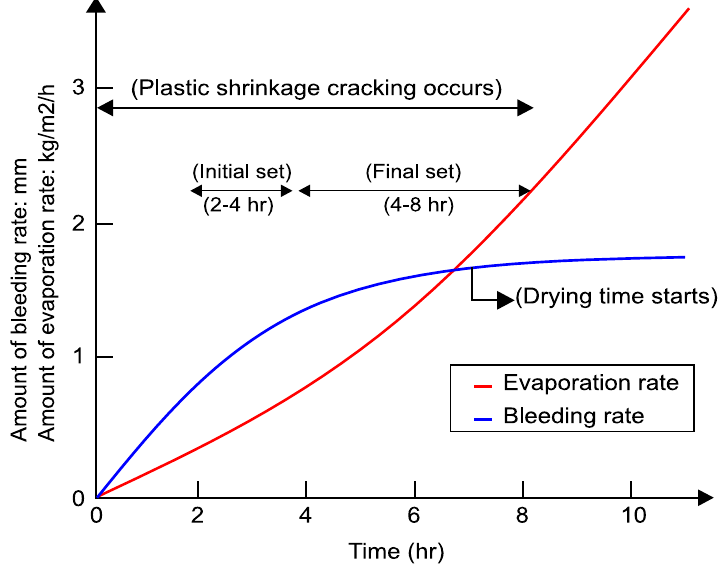
Figure 1. Evaporation and bleeding of